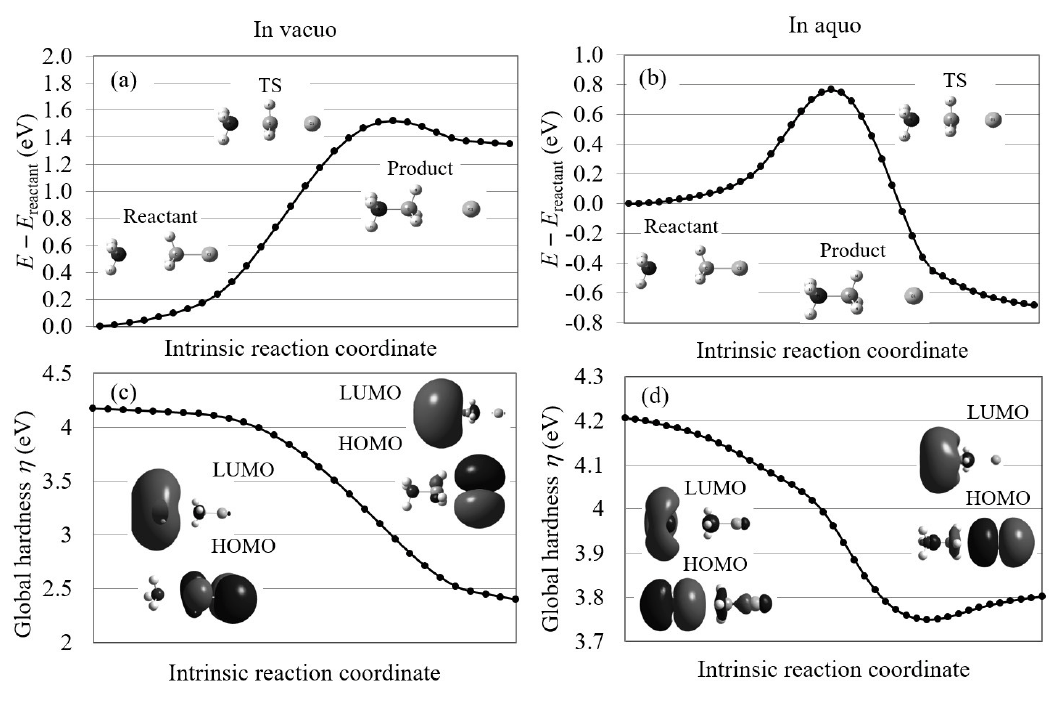
Figure 5. The potential energy curves and the global hardnesses of the Menschutkin reaction (NH 3 + CH 3 Cl → NH 3 CH + + Cl − ) in gas phase and in aqueous solution on their intrinsic reaction 3 coordinates, which are calculated by LC-BLYP/aug-cc-pVTZ. The images of the molecular orbitals mainly contributing to each reaction process are also